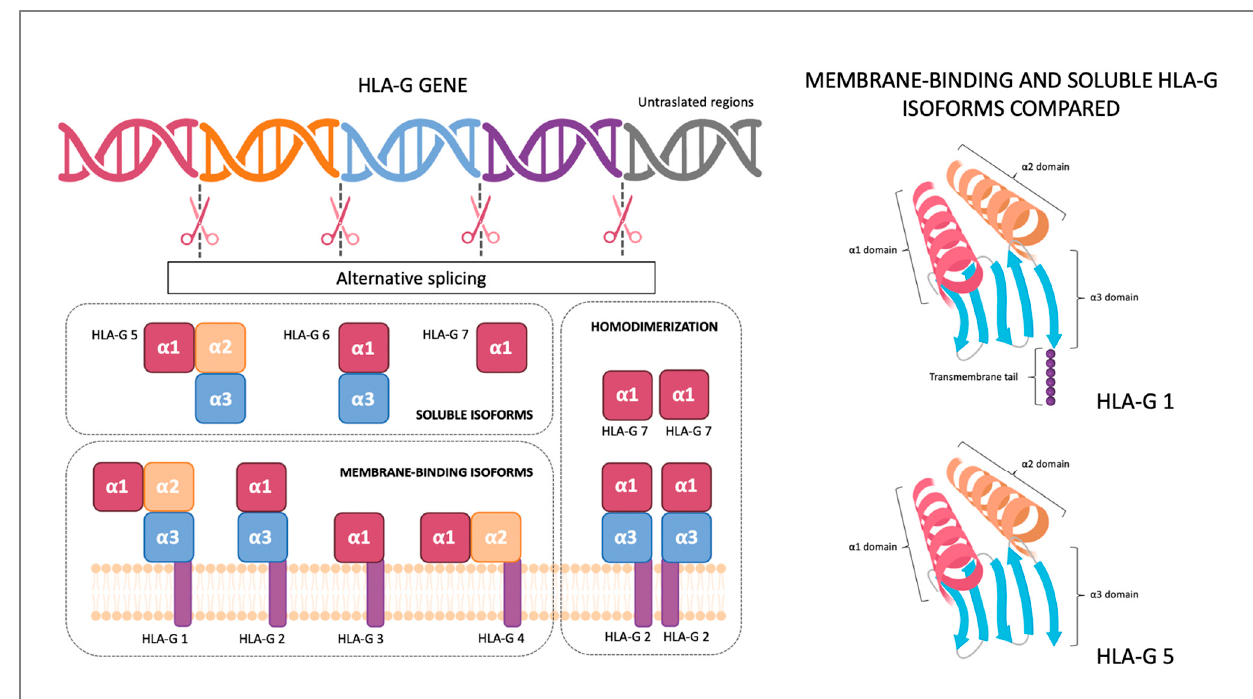
Figure 1. Human Leukocyte Antigen (HLA)-G isoforms. With mRNA-alternative splicing, seven HLA-G protein isoforms can be generated: HLA-G membrane-binding isoforms (HLA-G1, HLA-G2, HLA-G3 and HLA-G4) and HLA-G soluble isoforms (HLA-G5, HLA-G6 and HLA-G7). Both HLA-G membrane-binding isoforms and HLA-G soluble isoforms can form homodimers. As shown in the right side of the image, HLA-G 1 is characterized by a six amino acid-long cytoplasmic tail that anchors it to the cell membrane.